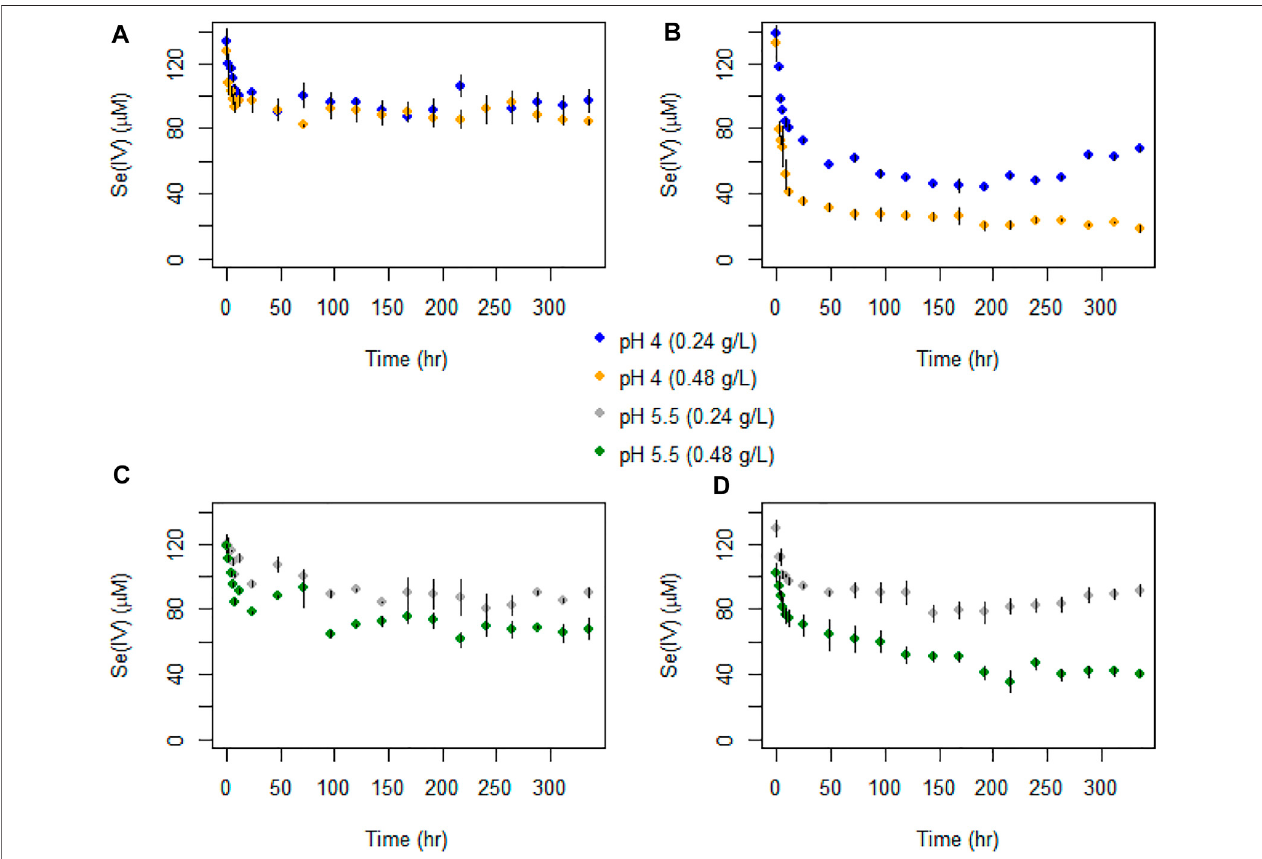
FIGURE6| TemporalevolutionofSe(IV)concentrationsinbatch experiments with (A) ARbirnessite atpH 4, (B) SGbirnessiteat pH4, (C) ARbirnessiteat pH5.5, and (D) SG birnessite at pH 5.5. All experiments were performed at 25 ° C with an initial Se(IV) concentration of 120 μ M. Error bars represent SDs for concentrations measured in